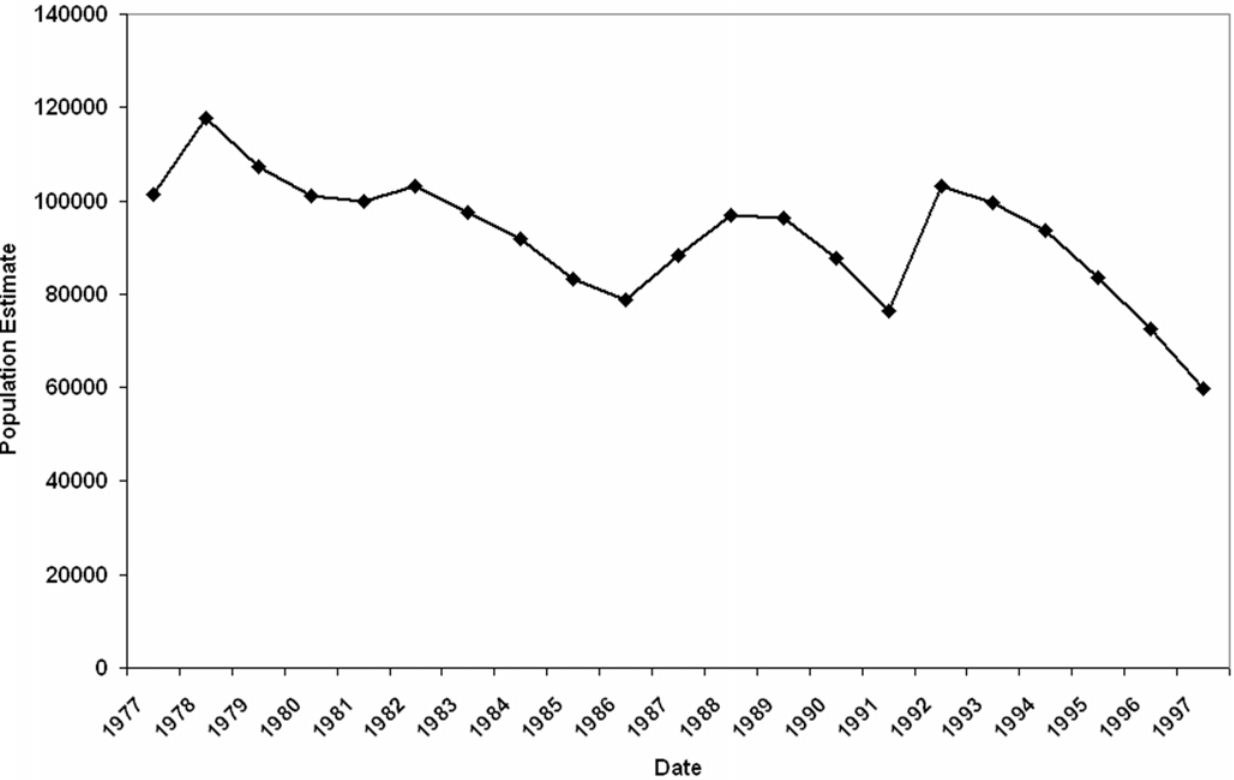
Figure 1. Combined wildlife population changes for Tsavo East, Tsavo West, Amboseli, Nakuru, Meru and Nairobi National Parks and between 1977 and 1997.